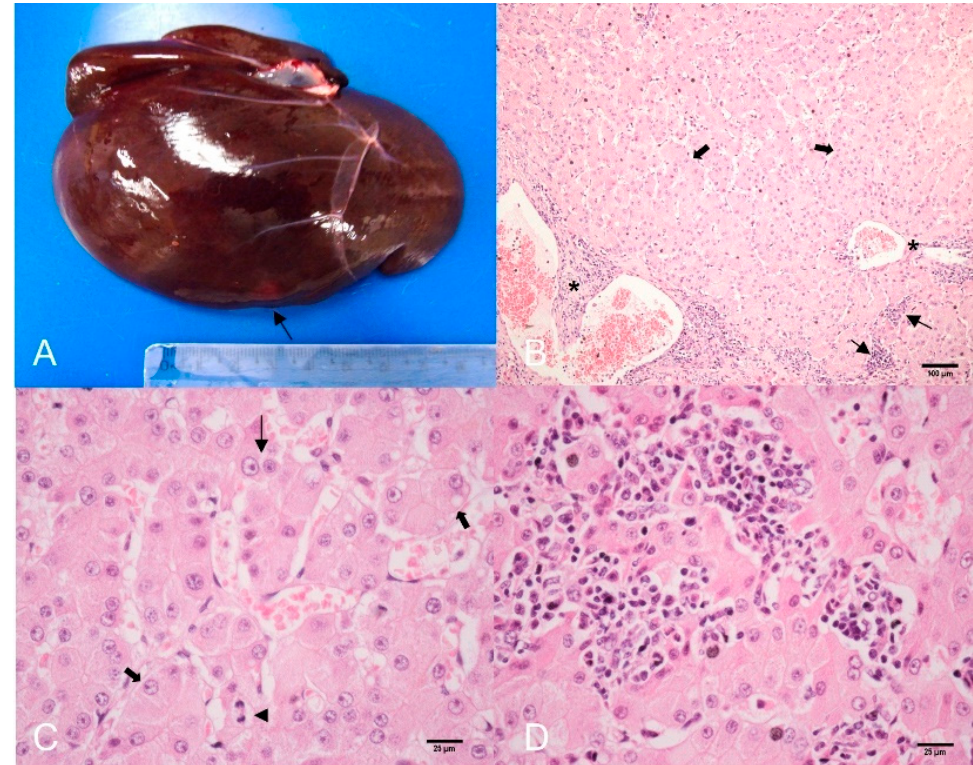
Figure 1. Hepatocellular carcinoma (HCC), liver, three-toed sloth ( Bradypus variegatus ). ( A ) Gross of liver showing HCC as a single whitish nodule (arrow) at the border of the left lobe. ( B ) Trabecular pattern HCC. Note thickened trabeculae containing 4 to >5 cells (thick arrows), lobular inflammatory infiltrate (thin arrows), and in pseudo portal spaces (*). HE. Bar 100 µm. ( C ) Well-differentiated neoplastic hepatocytes showing anisocytosis (thick arrows), anisocariosis (thin arrow), and mitosis figure (arrowhead). HE. Bar 25 µm. ( D ) Lymphocytic inflammatory infiltrate is observed within sinusoids and between neoplastic cells. HE. Bar 25 µm. Table 1. Details of primary antibodies applied for the immunohistochemical evaluation of three-toed sloth hepatocellular